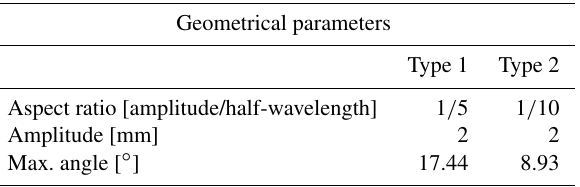
Table 1. Geometrical parameters for wrinkles configurations type 1 and type